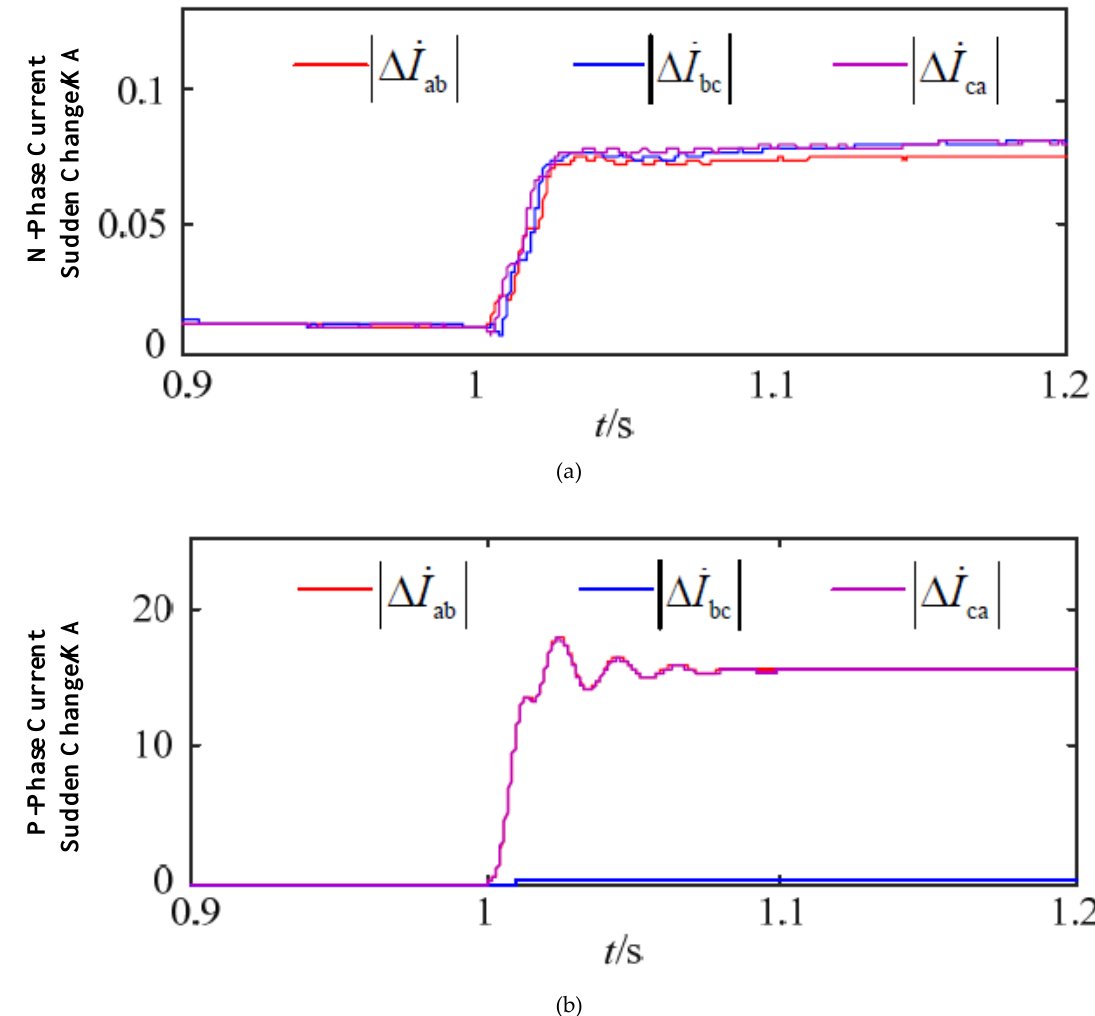
Figure 8. Phase A to ground sudden current change magnitudes analysis of the two-phase current difference: ( a ) N-phase, ( b ) P-phase.